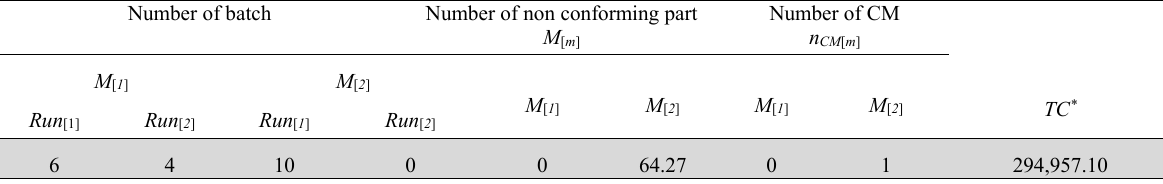
The best solution based on Algorithm [SITM] for constant batch